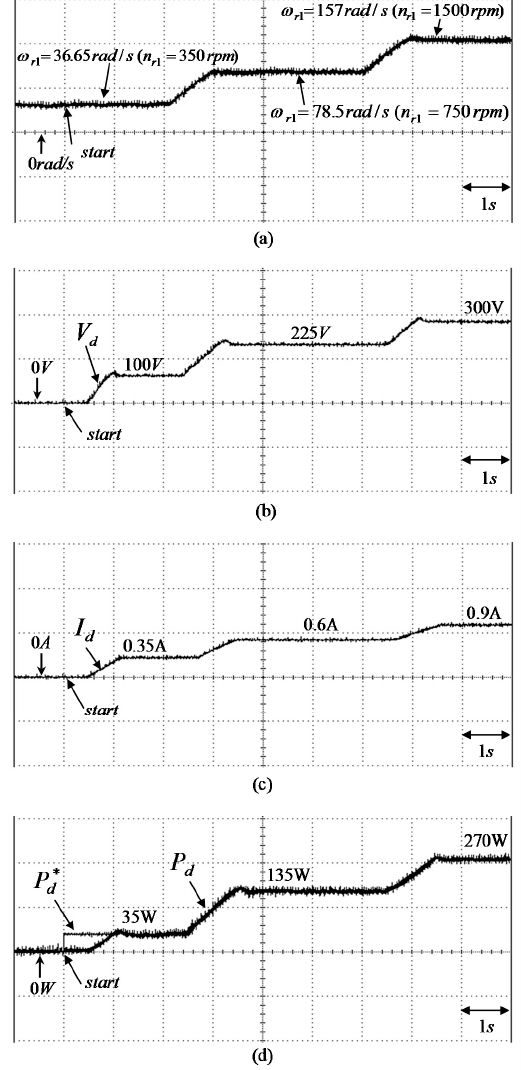
Figure 12. Experimental results of the WT driving PM synchronous generator system using the novel recurrent Chebyshev NN control system at step ‐ command changing of rotor speed: ( a ) rotor speed ω r 1 p n r 1 q ; ( b ) response of measured DC bus voltage V d ; ( c ) response of measured DC bus current I d ; ( d ) response of reference DC bus power P ˚ and DC bus power P d d